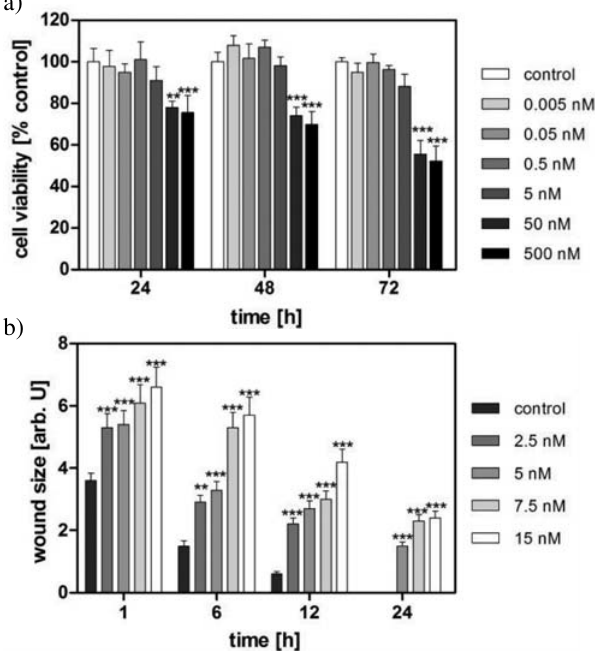
Figure 2: Effects of Vaa -Dis on breast cancer cells. (a) As estab- lished by PrestoBlue TM cell viability testing, the cytotoxicity of Vaa -Dis for MDA-MB-231 cells is evident at 50 nM and higher concentrations. Each result is an average of three independent ex- periments. (b) The wound-healing assay on MDA-MB-231 cells was performed in the presence of Vaa -Dis at concentrations, which did not affect cell viability. Each result is an average of three inde- pendent experiments. Units are arbitrary (arb. U). Statistical signi- ficance is displayed as follows: no mark for p > 0.05 (not signifi- cant), * for p ≤ 0.05, ** for p ≤ 0.001 and *** for p ≤